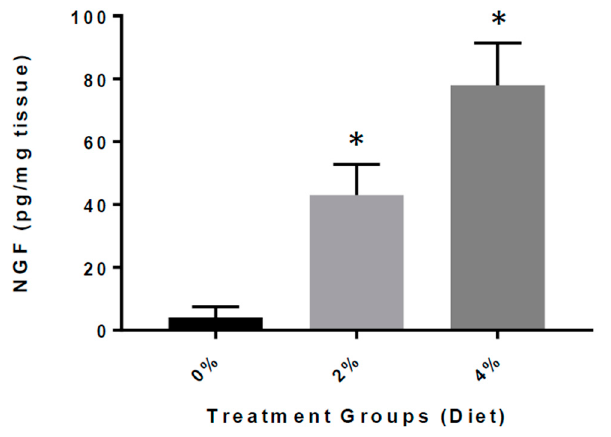
Figure 7. Concentration of NGF in the brain of APP/PS-1 mice. Bar graphs show the concentration of NGF in picograms (pg) per milligram (mg) of brain tissue from APP/PS-1 mice treated with GF diets (2 or 4%) versus APP/PS-1 mice untreated. The difference was statistically significant (* p < 0.001; n = 20 per group).